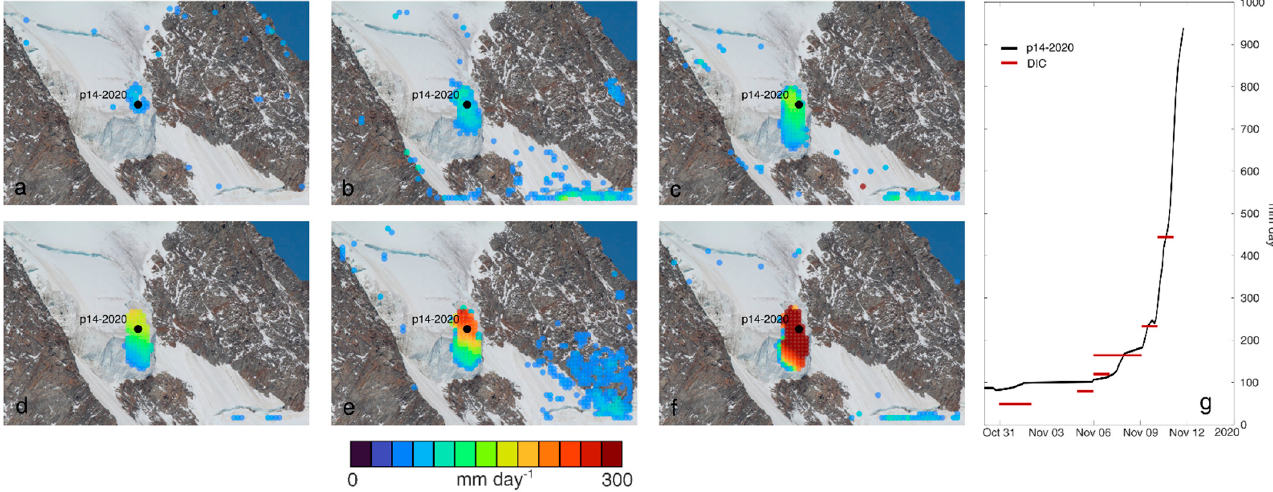
Figure 6. ( a – f ) Mean daily velocity (calculated as the sum of the two displacement components orthogonal to the LOS) of the Whymper Serac measured with DIC. The results were obtained by processing the images between 31 October–2 November; 5–6 November; 6–7 November; 6–9 November; 9–10 November; and 10–11 November 2020, respectively. ( g ) The black line refers to the velocity of the prism p14-2020 that was placed onto the surface of the ice chunk of approximately 20,000 m 3 that broke-off on 11 November 2020, while the horizontal red lines indicate the mean daily velocity obtained with the DIC in correspondence of the prism. Both DIC and RTS data evidenced the acceleration of the ice chunk. The height of the serac face is approximately 40 m.